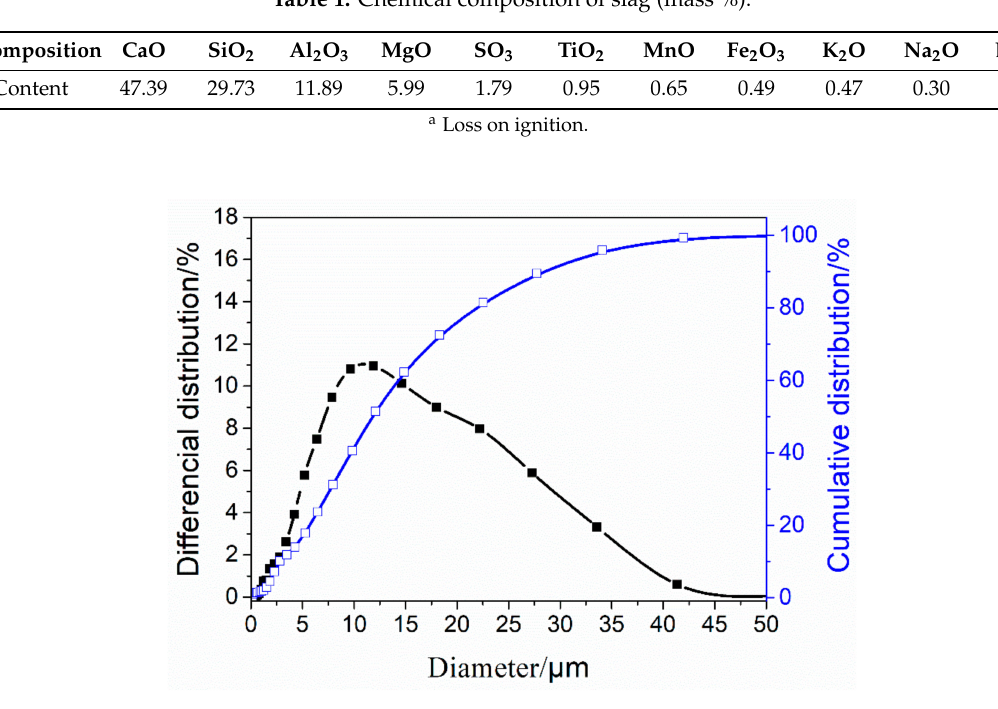
Figure 12. Particle size distribution of slag used as AAM precursor.